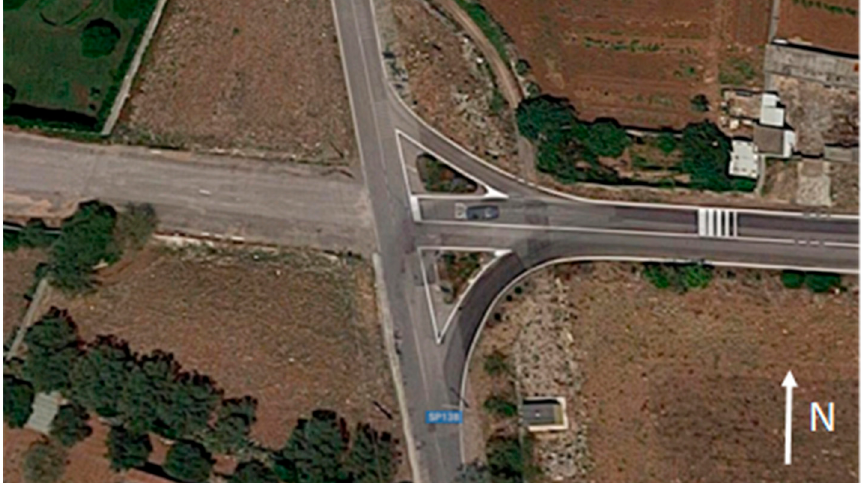
Figure 1. The intersection to redesign (photo: Google maps).